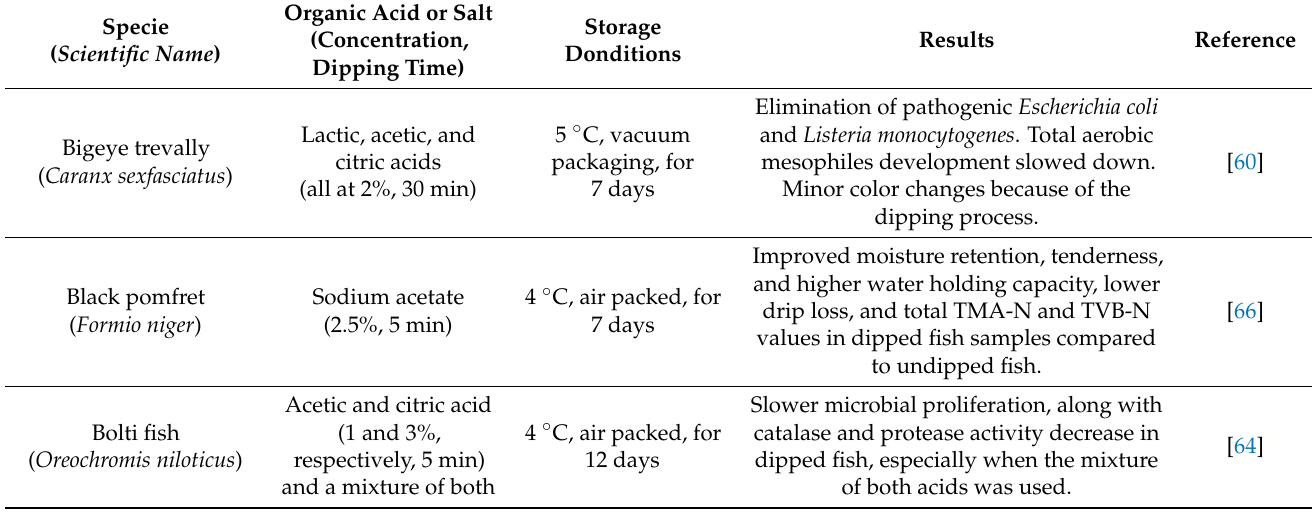
Table 3. Literature regarding the effects of organic acids dipping and spraying on fresh